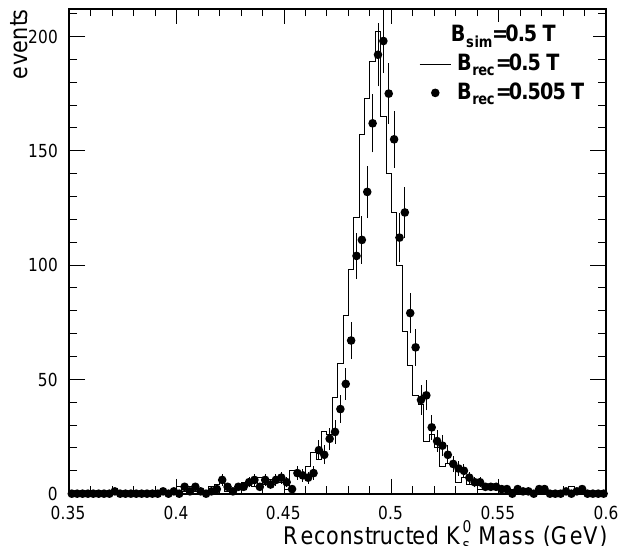
Figure 58. The invariant mass distribution for reconstructed K 0 s generated as single particle events inside the HPgTPC and then reconstructed in GArSoft with an efficiency of about 33%. The kaon mass ( m K 0 = 497.6MeV according to the PDG) is well reproduced by the mean of the distribution, and a 1% bias in the magnetic field (and therefore also in the momentum) results in a clear shift of the